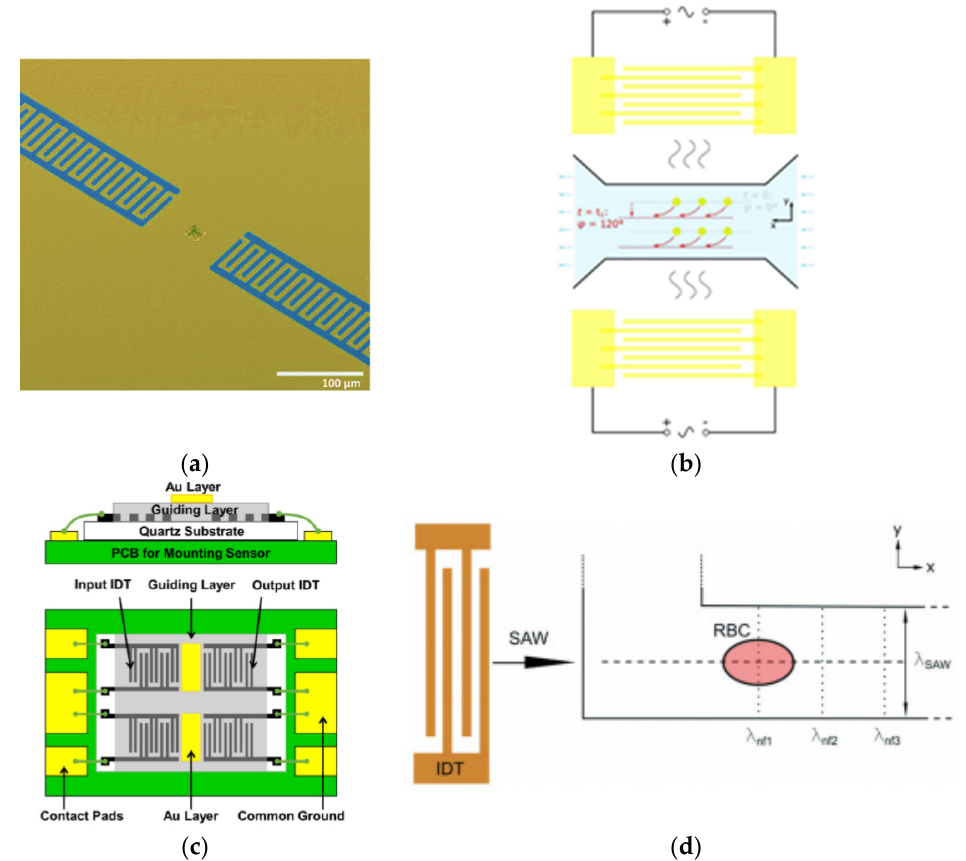
Figure 10. ( a ) A fabricated SAW device with a microcavity at the centre of two IDTs. ( b ) The SAW microfluidic chip and its operation. Particles are initially prefocused at the pressure node when t = 0, and when t = t1, all prefocused particles are moved to the new nodal line. ( c ) SAW device with IDTS on quartz substrate and the thin gold layer is deposited on top of the guiding layer to enhance the cell adhesion on the sensing area. ( d ) The sampling part of the acoustic erythrocytometer. Images were reproduced with permission from previous authors [78–81].